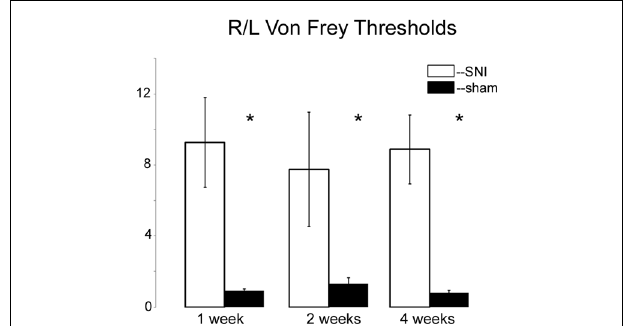
FIGURE 3 |Von Frey measurements in SNI and sham rats. The spared nerve injury (SNI) model of neuropathic pain was used.The left or ipsilateral nerve was injured while the right or contralateral nerve was intact.Tactile sensitivity of the spared region of the operated paws was measured from the withdrawal responses to mechanical stimulation with von Frey filaments. 50% response thresholds were calculated according to Chaplan etal. (1994). Data are shown by dividing the contralateral/right paw over the ipsilateral/left paw, at 1, 2, and 4 weeks post SNI or sham surgery. All animals that underwent SNI surgery developed significant tactile allodynia in the ipsilateral/left paw that persisted until they were sacrificed, while sham rats showed no changes, * p < 0.01. n = 8 SNI and sham for 1 week, 4 for 2 weeks, and 6 for 4 weeks.The left foot von Frey thresholds for sham-operated and SNI rats, respectively, were 3.93 ± 0.58 g and 0.55 ± 0.41 g at 1 week, 5.16 ± 0.49 g and 0.64 ± 0.16 g at 2 weeks,